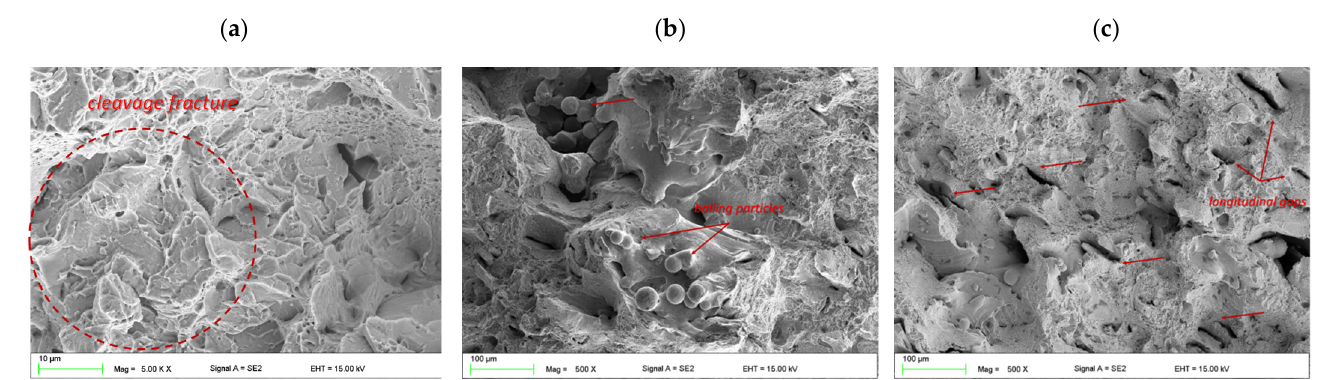
Figure 13. Fractured surface features of the AM maraging steel M789 in aging conditions: ( a ) 3 h, ( b ) 6 h and ( c ) 9 h . ( b ) 6 h and ( c ) 9